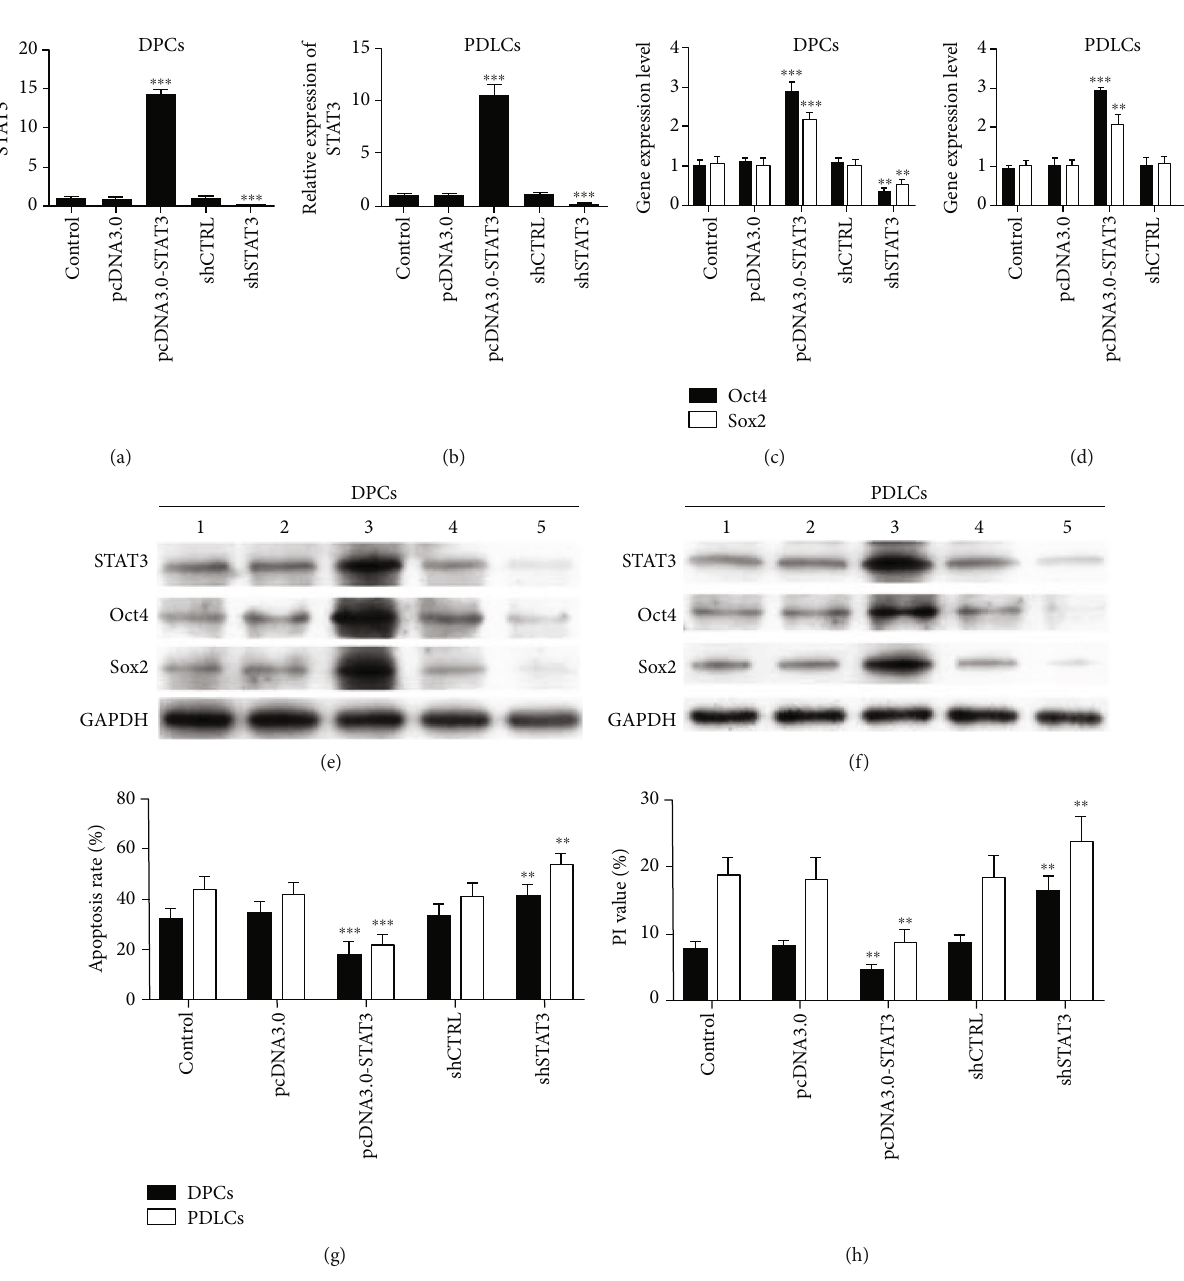
Figure 6: STAT3 overexpression and silence models were established in DPCs and PDLCs. The results of PCR and WB showed that STAT3 was signi fi cantly enhanced and silenced in DPCs and PDLCs (a, b, e, and f, ∗∗∗ P < 0 : 001 ). Oct-4 (c, d) and Sox2 (c, d) showed similar patterns of mRNA expression, consistent with the overexpression or silence of STAT3 , and both mRNA levels were signi fi cantly upregulated or downregulated in both DPCs and PDLCs ( ∗ P < 0 : 05 , ∗∗ P < 0 : 01 , and ∗∗∗ P < 0 : 001 ). The results of western blot showed that the levels of Oct-4 and Sox2 proteins were signi fi cantly increased or reduced in DPCs and PDLCs (e, f). The apoptosis rates of DPCs and PDLCs were signi fi cantly reduced compared with the control group (g, Table 6, ∗∗ P < 0 : 01 and ∗∗∗ P < 0 : 001 ). The cell cycles of both DPCs and PDLCs were arrested at the G0/G1 phase (h, Table 6, ∗∗ P < 0 : 01 ). 1: group of control; 2: group of pcDNA3.0; 3: group of pcDNA3.0-STAT3; 4: group of shCTRL; and 5: group of